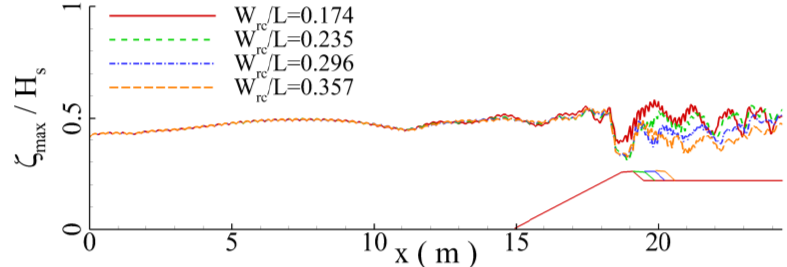
Figure 55. Space distributions of the local maximum water elevation.